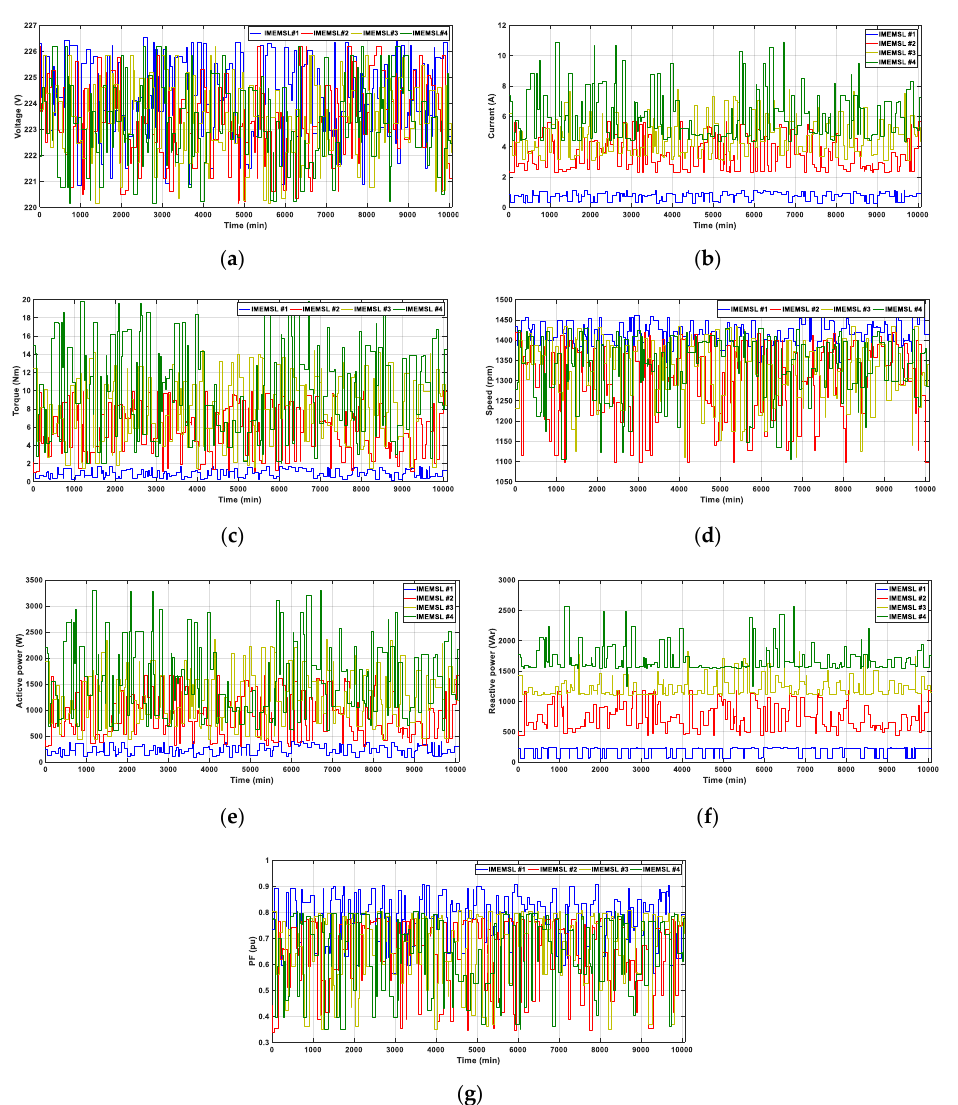
Figure 11. Electricals and mechanicals variables measured of IMs: ( a ) v; ( b ) I; ( c ) T; ( d ) n; ( e ) p; ( f ) q; ( g ) PF.